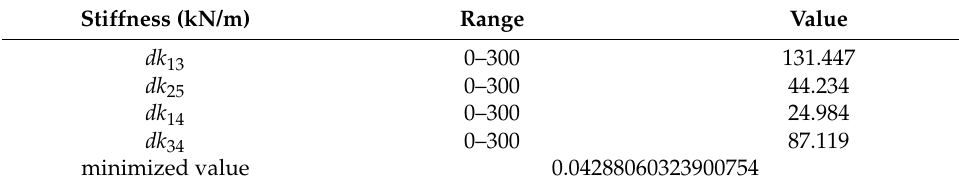
Figure 15. Modified structure after the addition of connection stiffness. Table 9. Parameters of added connection stiffness.